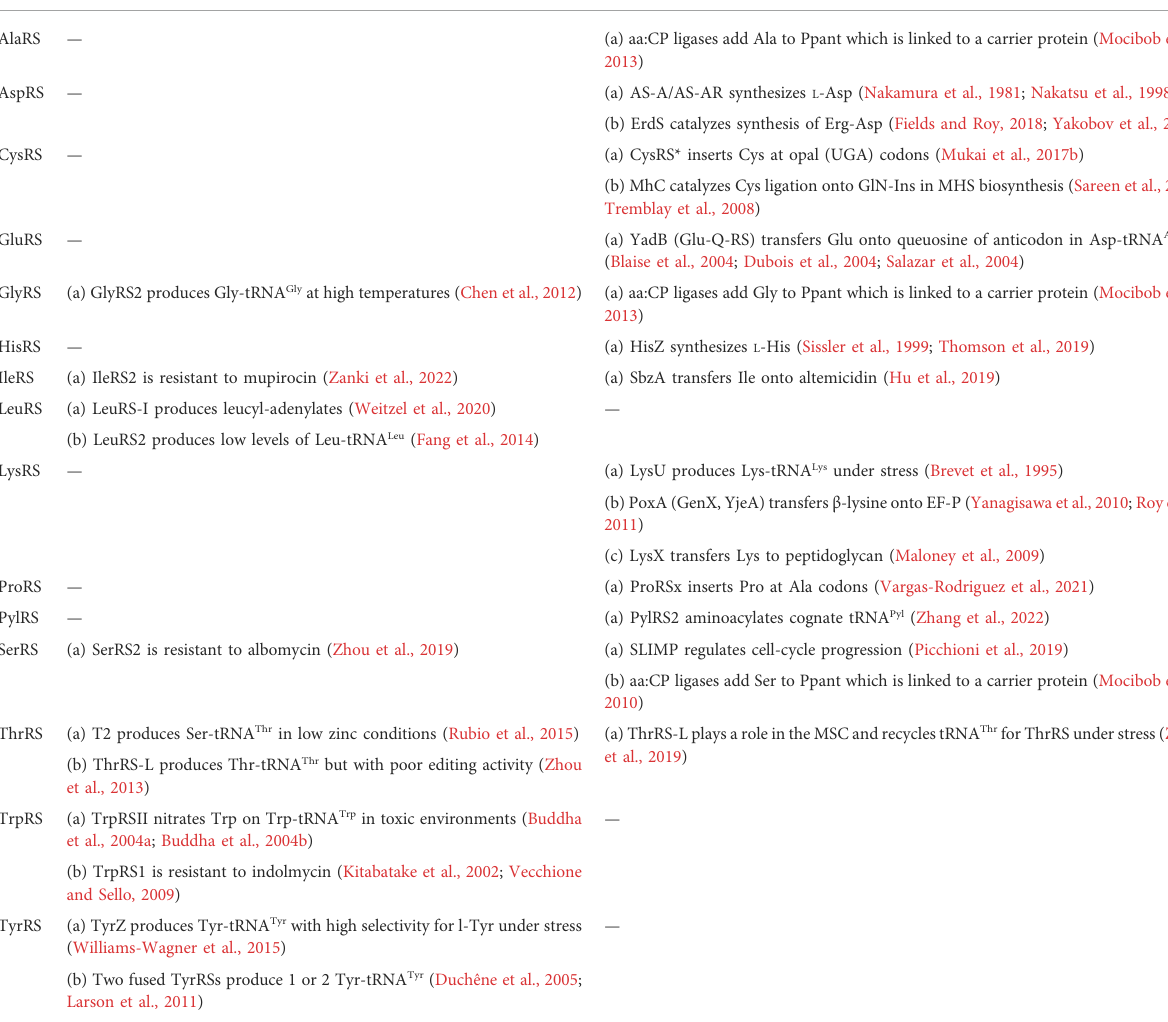
TABLE 1 List of duplicated aminoacyl-tRNA synthetases and their evolved function. aaRS Auxiliary